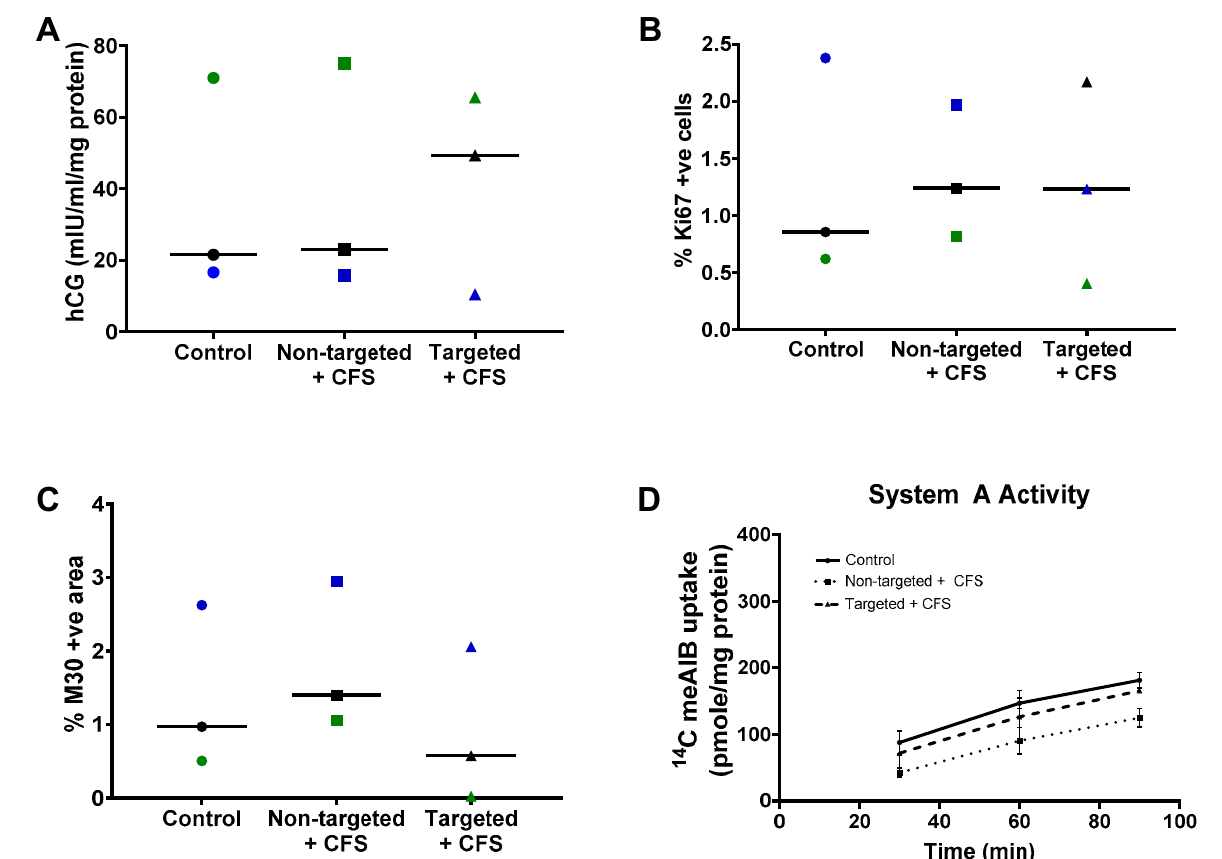
Figure 2. Liposomal formulations do not alter normal placental function. Healthy third-trimester human placental explants were cultured for 7 days and treated with either 10 µ L PBS (control), undecorated liposomes encapsulating carboxyfluorescein cargo (Non-targeted + CFS) or GPS-decorated liposomes encapsulating carboxyfluorescein cargo (Targeted + CFS) for 48 h on days 5–7. hCG secretion; n = 3 ( A ), cells positive for Ki67; n = 3 ( B ), M30-positive area; n = 3 ( C ), and System A amino acid transporter activity; n = 2–3 ( D ), measured 48 h after treatment (day 7). Matched samples are shown in blue, green or black in ( A − C ). Median values are shown. Data not significantly different. hCG = human chorionic gon- adotropin.